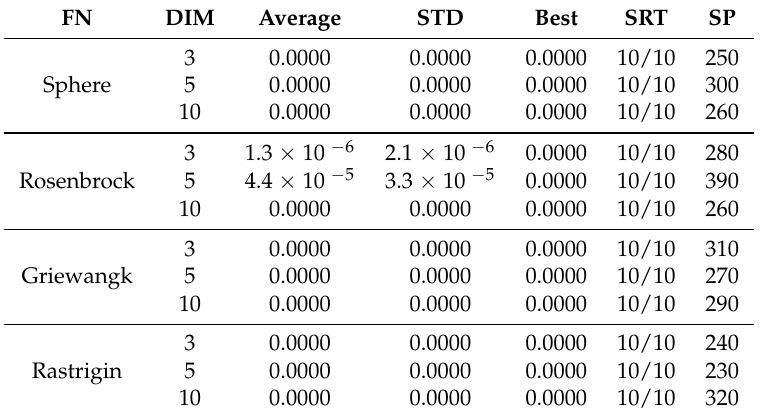
Table 2. Simulation results of the proposed BCSO